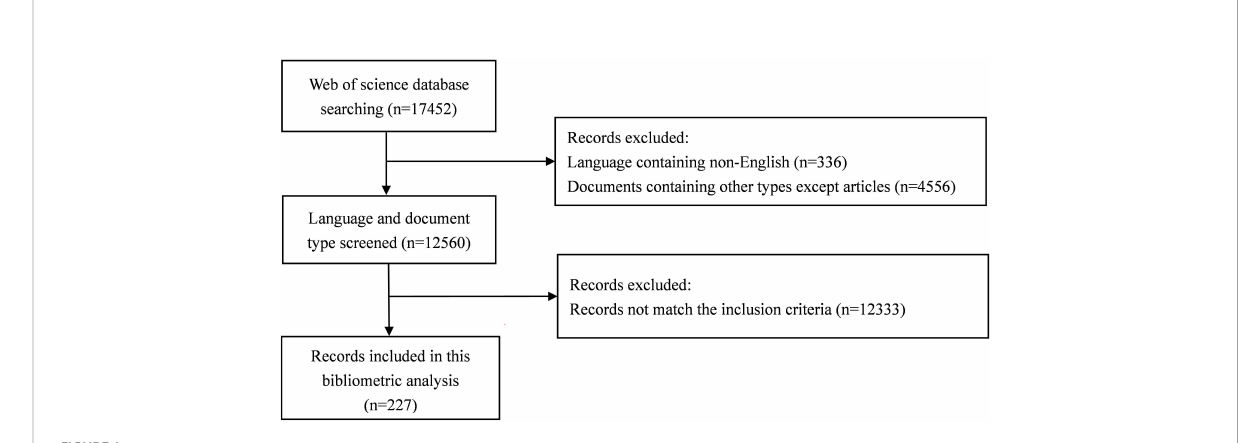
FIGURE 1 The fl owchart of the literature screening